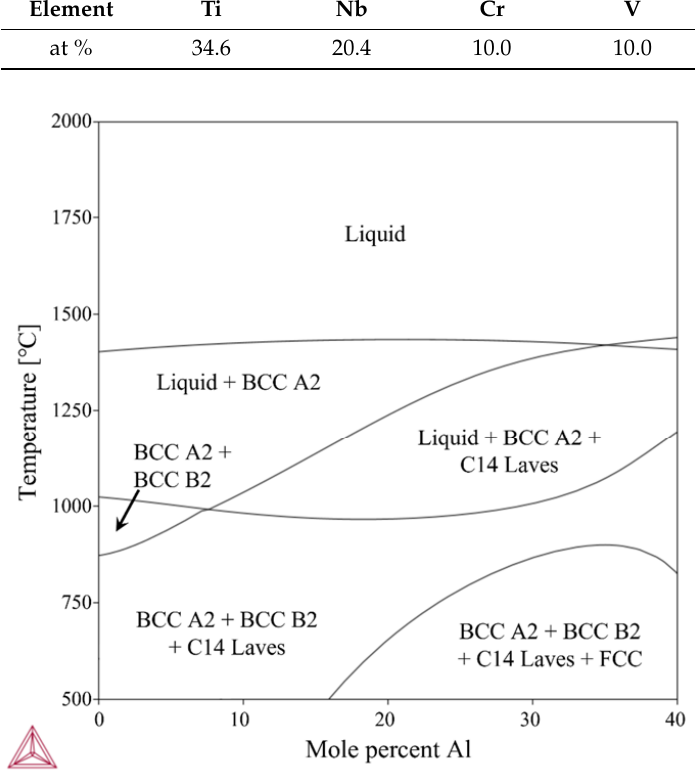
Figure 2. The phase diagram of Ti ‐ Nb ‐ Cr ‐ V ‐ Ni ‐ Al.